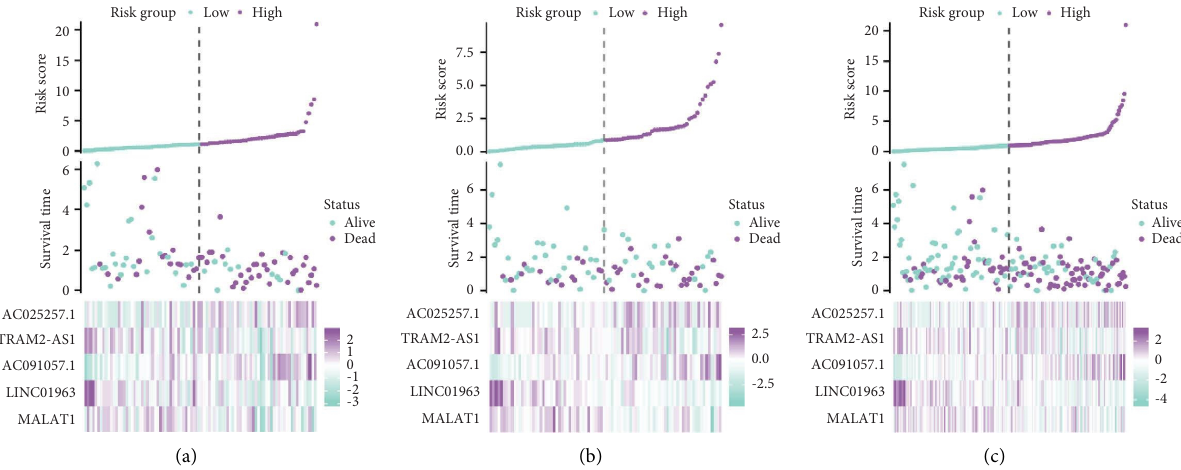
Figure 2: Te distribution of risk score, patient survival time, patient status, and expression level of fve lncRNAs for pancreatic cancer. (a) Training set. (b) Validation set. (c) Entire